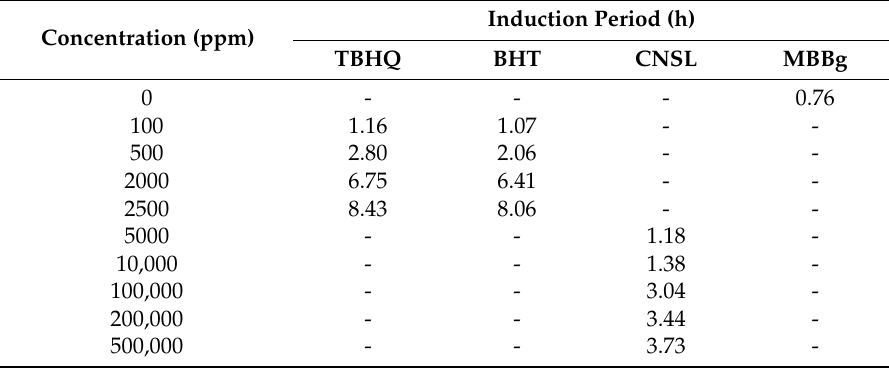
Table 3. Induction periods obtained to the methyl biodiesel of B. glabra (MBBg) doped TBHQ, BHT or CNSL at different